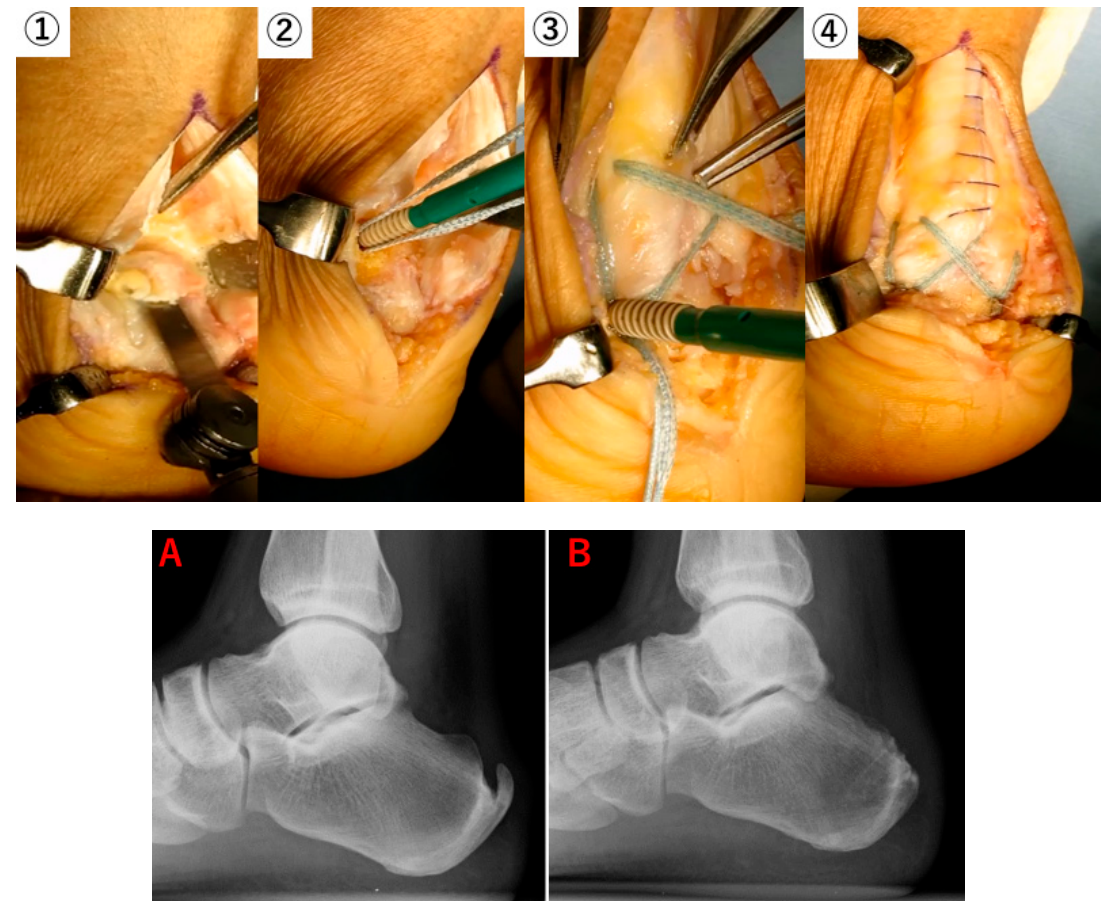
Figure 2. We performed a reconstruction of the Achilles tendon with a suture bridge technique. ① : Bone spurs, calcifications in the tendon, and Haglund’s prominence is removed. ② : Two Swive Locks with Fiber Tape inserted in the proximal hole. ③ : Fiber Tape is passed through the Achilles tendon and inserted into the prepared distal hole using Swive Lock. ④ : The tails on the distal row flushed to the anchor. ( A ): Preoperative X-ray. ( B ): Postoperative X-ray for the same case.